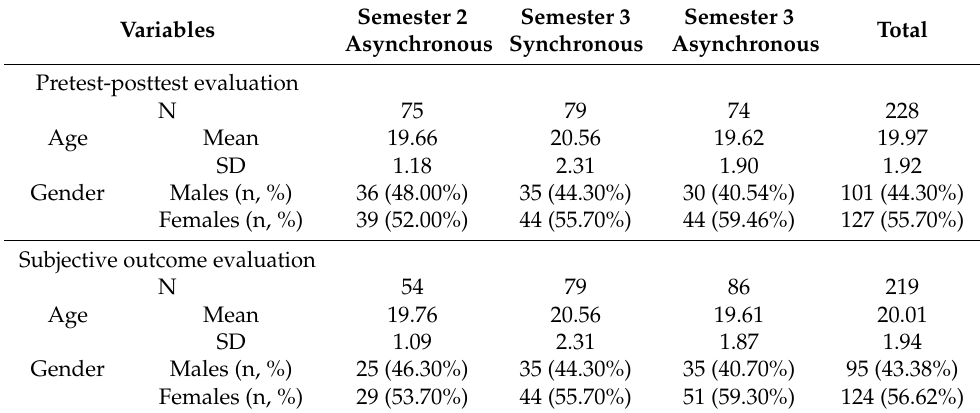
Table 1. Description of the matched sample in the pretest-posttest